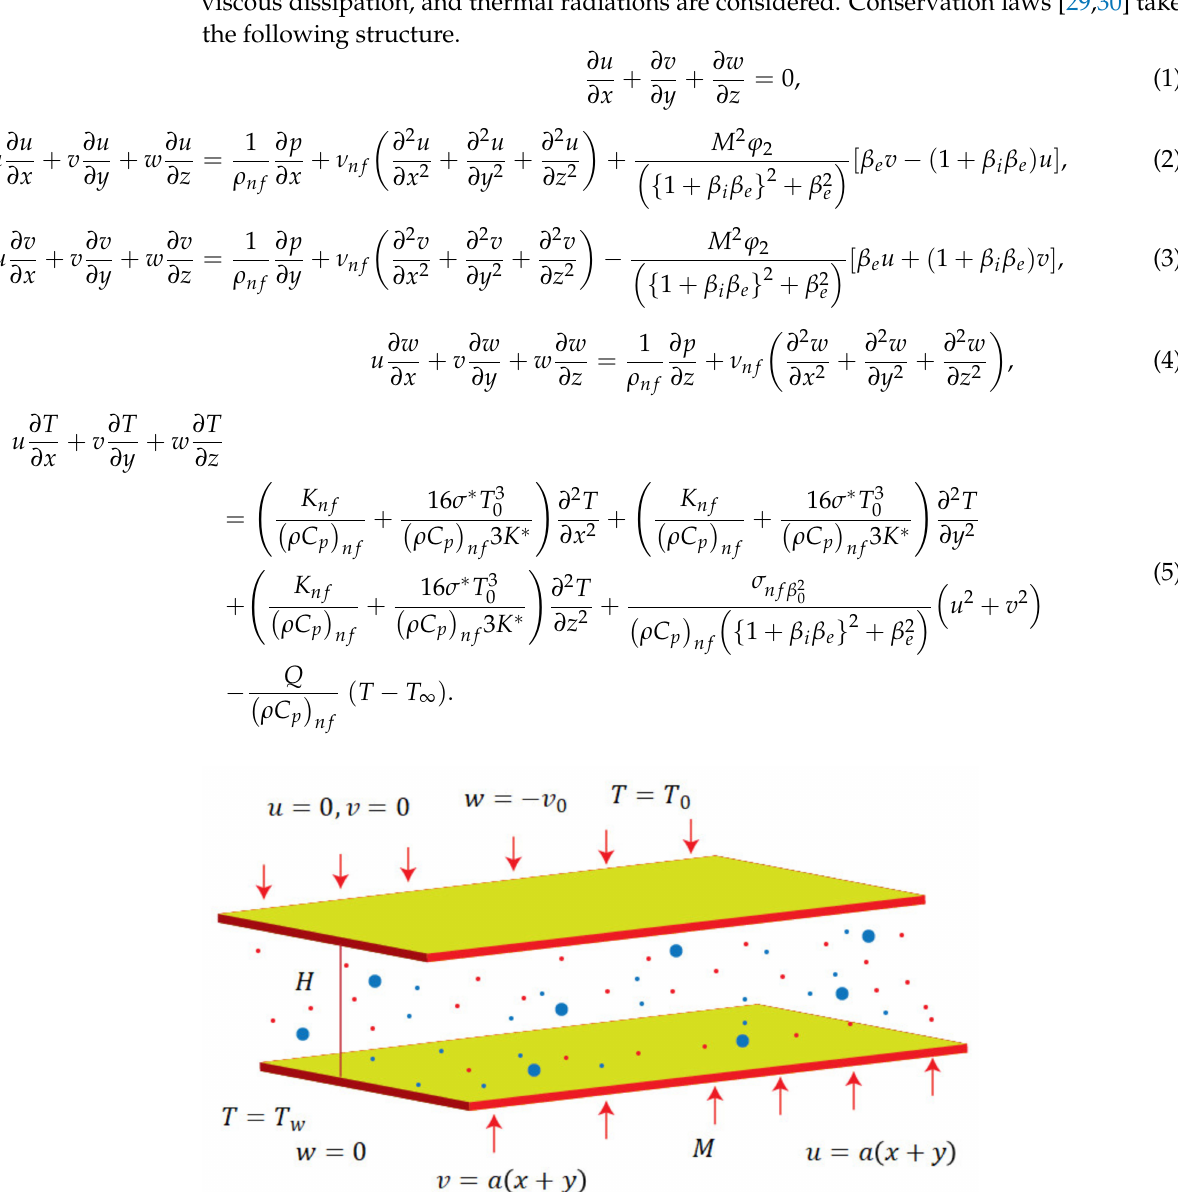
Figure 1. Flow of fluid particles. In above Equations (1)–(5), ( P ) the pressure, β e (= ω e τ e ) the ion slip parameter, β i (= ω i τ i ) the Hall parameter, ( T ) the temperature, ( T ∞ ) the temperature far away from the surface, ( Q ) denotes heat generation/absorption, ( u , v and w ) are the velocity compo- nents in x , y , and z -directions, respectively, ( β 0 ) the constant magnetic field. The wall of channel at z = 0 is stretched with different velocities a > 0, b > 0 and the wall at z = H is at rest and porous; ( u nf , ν nf , k nf , ( c p ) nf , ρ nf and σ nf ) are the dynamic viscosity, kinematic viscosity, thermal conductivity, specific heat, density and electrical